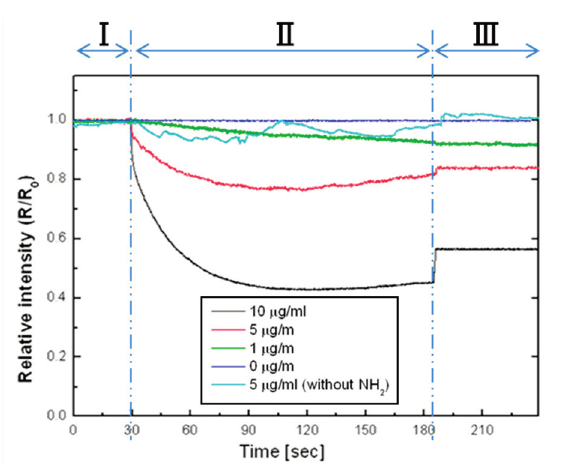
Figure 19. The reflective intensity from the multi-layer-PSi Region I: Absence of a magnetic field (H = 0). Region II: Application of a magnetic field (H = 500 Oe) Region III: After rinsing with PBS solution without a magnetic field (H = 0). Adapted from